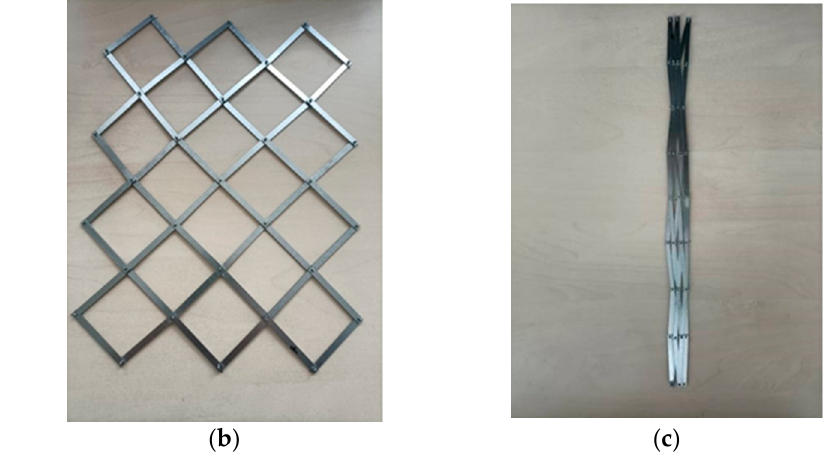
Figure 11. A structure made of metal bars connected to each other by axes of rotation at different stages of folding; pseudo-construction of rotating squares in the closed position ( a ) and in the open position ( b ) and folded state ( c ).